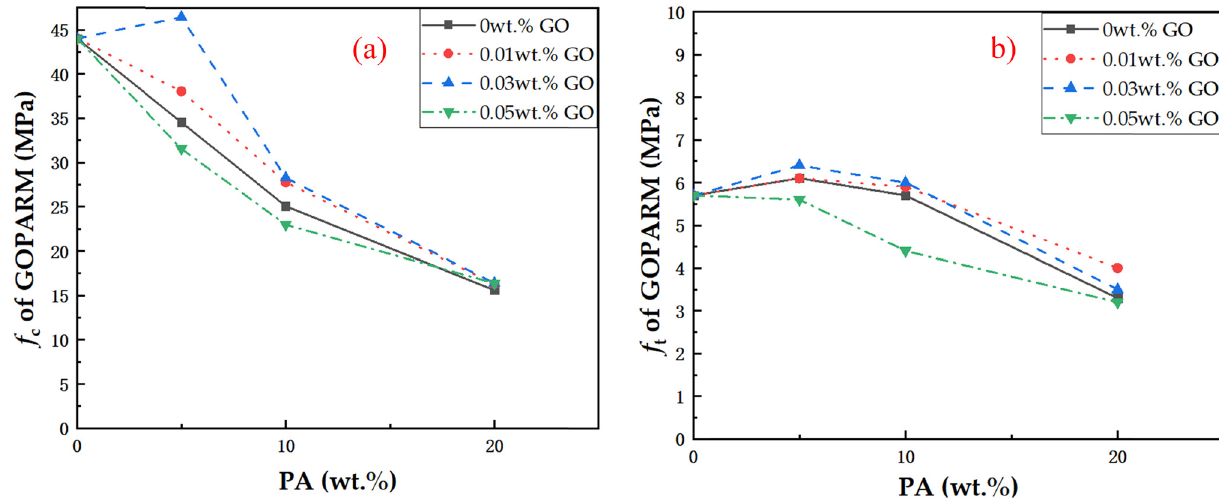
Figure 3: Variation curves of 7 days f c s and f t s of GOPARMs with di ff erent PA and GO dosages: ( a ) f c ; ( b ) f t